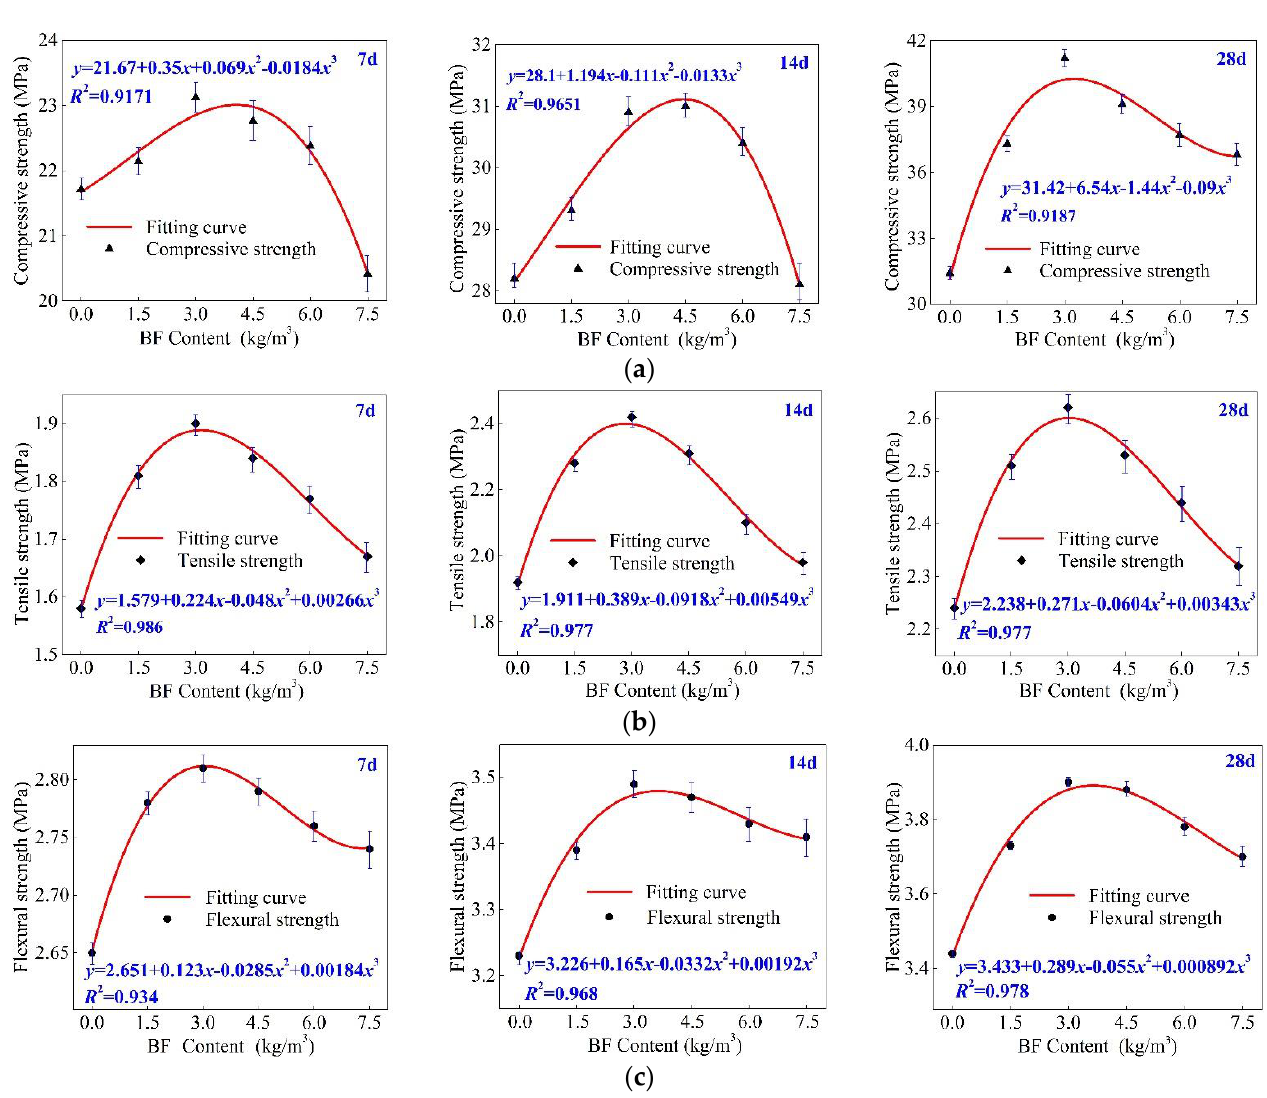
Figure 5. ( a ) Compressive strength. ( b ) Tensile strength. ( c ) Flexural strength (7 d, 14 d, and 28 d). Table 6. Compressive, tensile, and flexural strength of BF concrete with different BF contents.